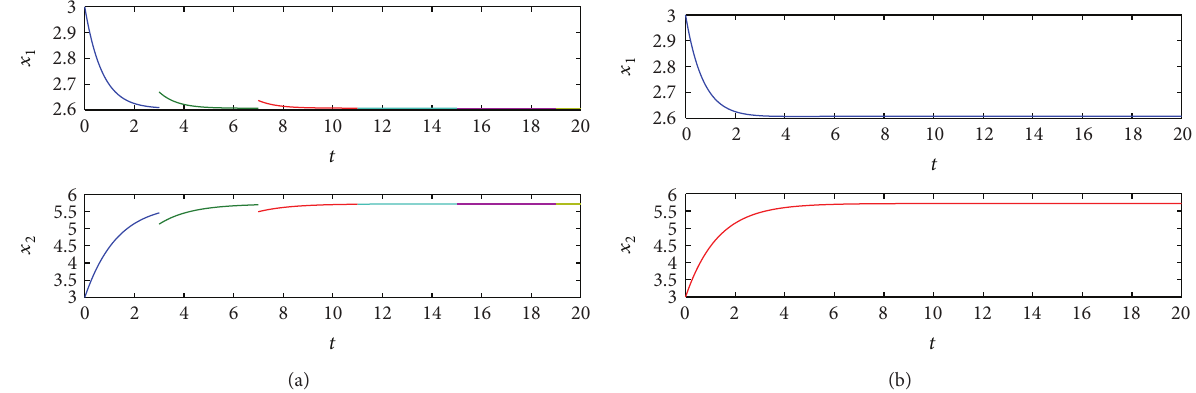
Figure 2: (a) The simulation, where the initial value is chosen as (3, 3) 𝑇 , illustrates that all trajectories uniformly converge to the unique equilibrium 𝑥 ∗ = (2.608, 5.719) 𝑇 for the ICNNs (61) with impulsive effects. (b) The simulation, where the initial value is chosen as (3,3) 𝑇 , illustrates that all trajectories uniformly converge to the unique equilibrium 𝑥 ∗ = (2.608, 5.719) 𝑇 for the ICNNs (61) without impulsive